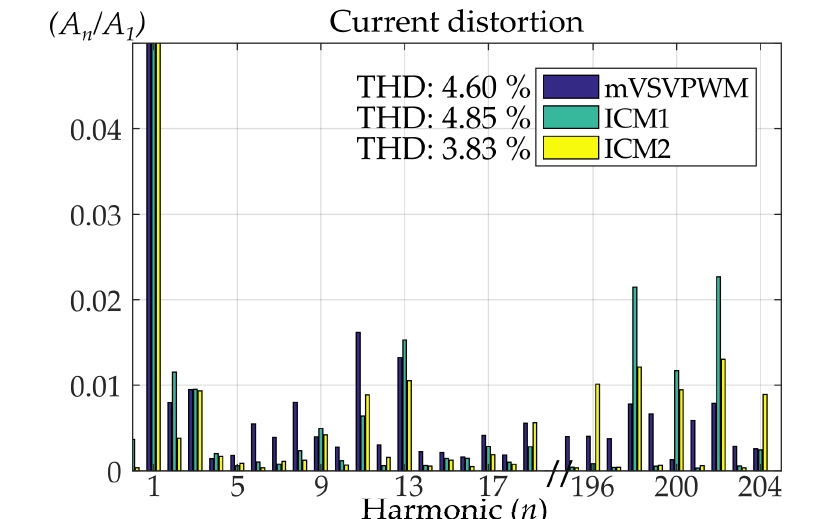
Figure 7. Experimental results: evolution of the capacitor voltages starting from an unbalanced condition, considering mVSVPWM (VSV in the figure), ICM1 and ICM2.